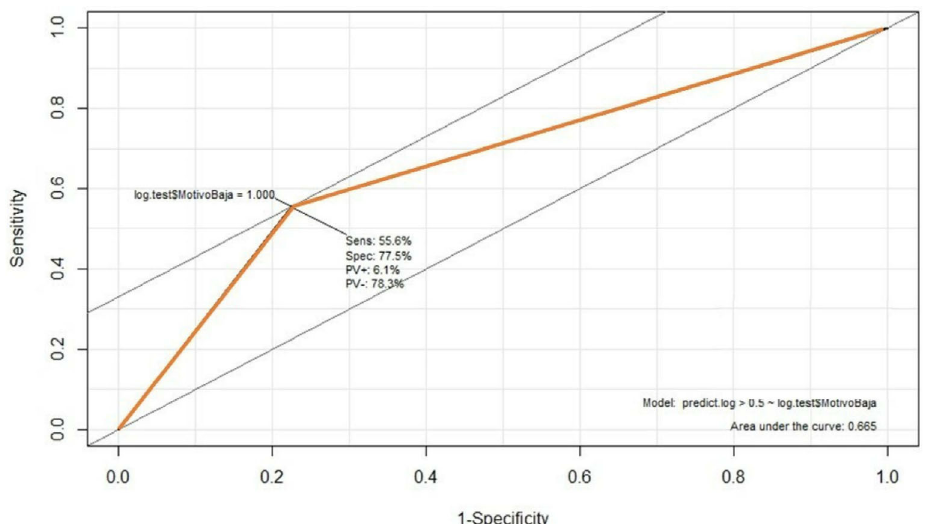
Figure 6. Receiver Operator Characteristic curve